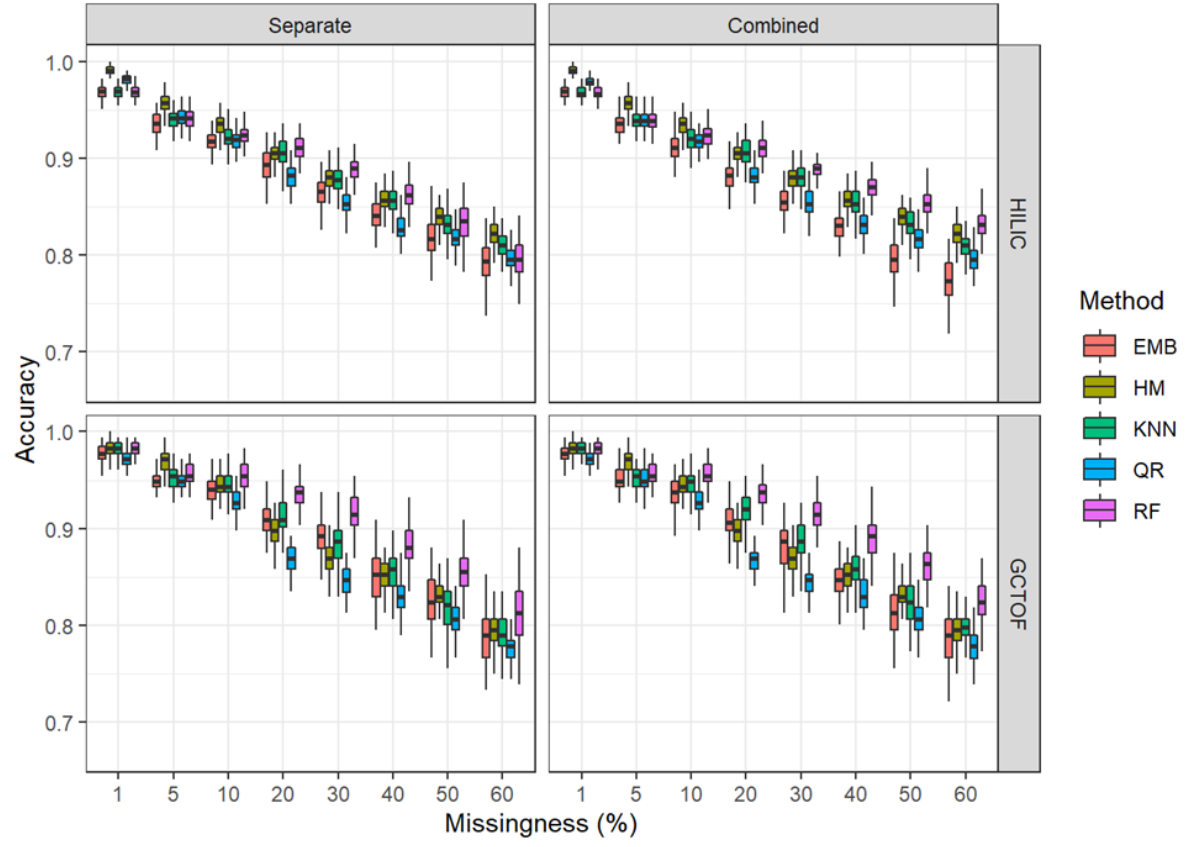
Figure 6. Box and whisker plots for accuracy for HILIC and GCTOF data sets.